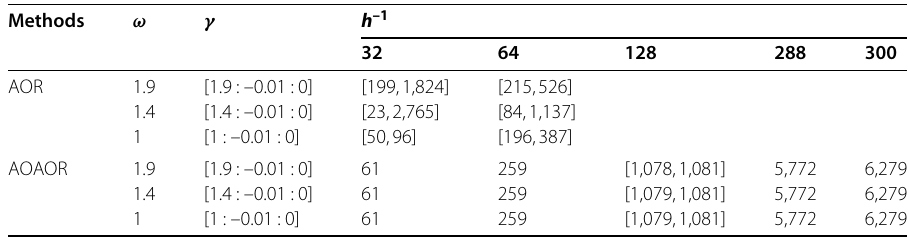
Table 8 The gap of IT when ξ = 30.0, ζ = 0.0, σ = 10.0 ( ε = h 2 ) Methods